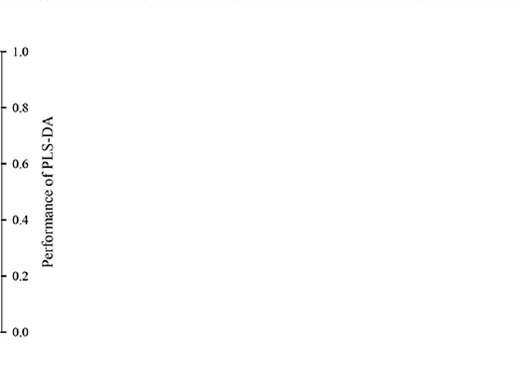
Figure 2. Significance analysis of phenotypic traits with p value threshold as 0.05. The solid horizontal line represents p = 0.05, i.e. - log 10 (p) = 1.301.